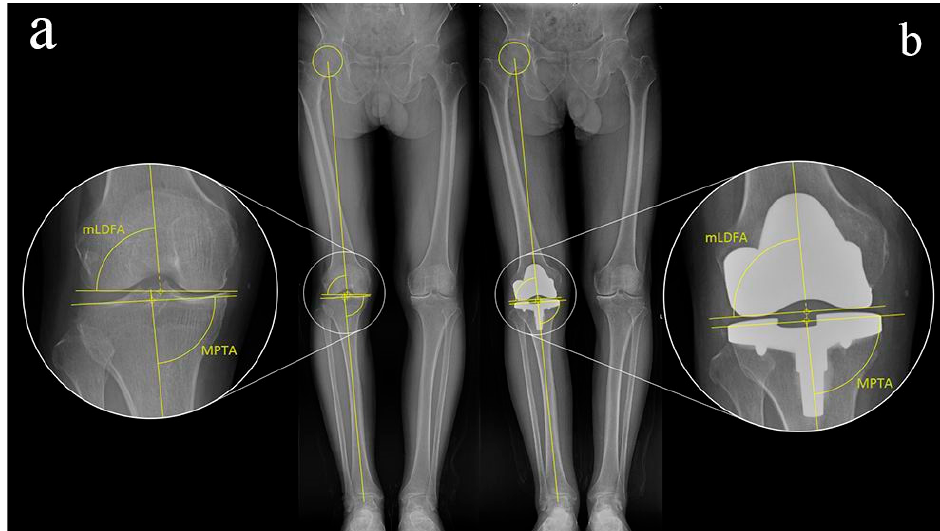
Figure 7. Measurement of the preoperative ( a ) and postoperative ( b ) joint line orientation parameters. mLDFA mechanical lateral distal femoral angle, MPTA medial proximal tibial angle.